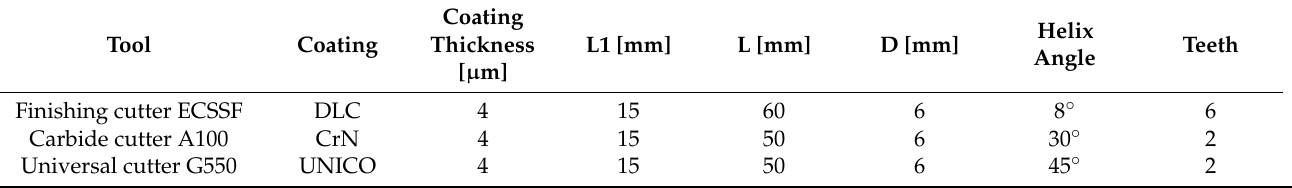
Table 2. General properties of